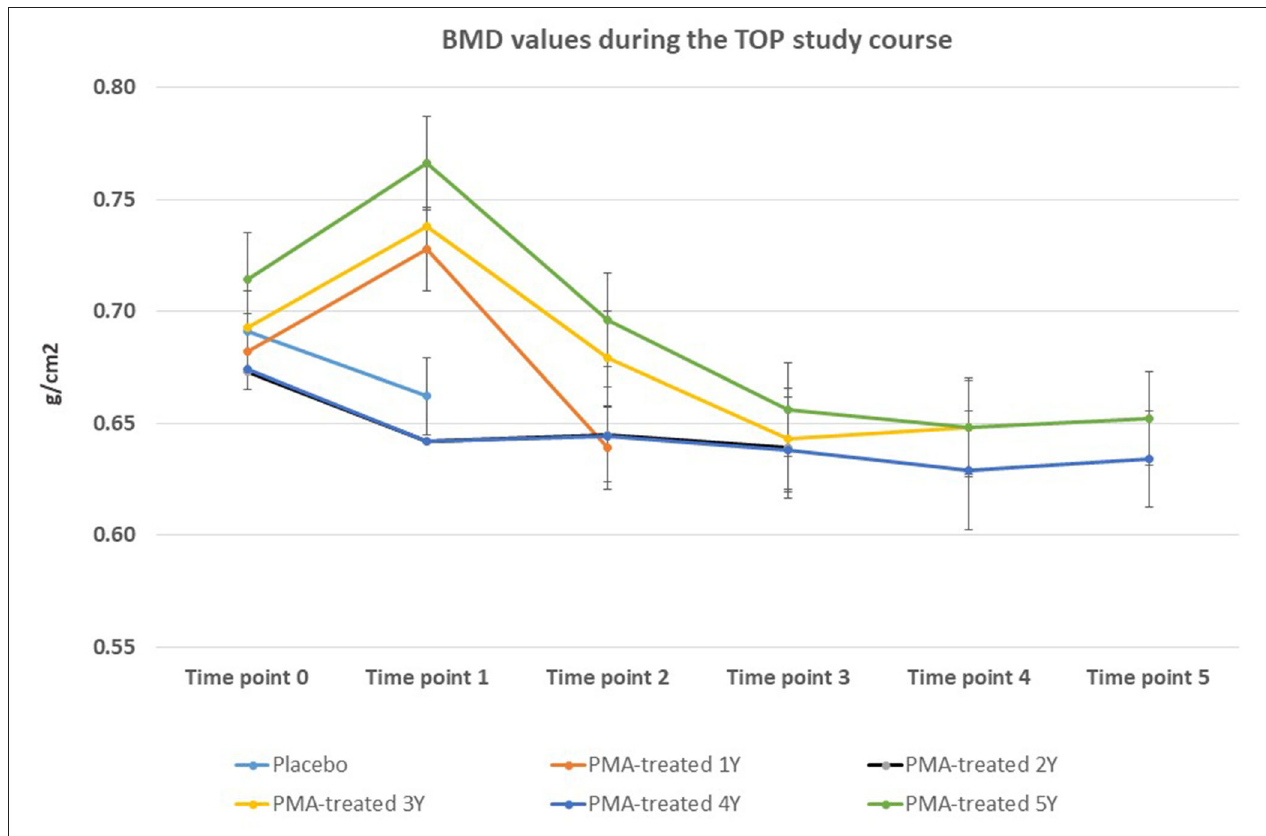
FIGURE 2 | Changes in BMD values from the beginning of the study (time point 0) until the end of study (time point 5) for Placebo and PMA-treated patients. A separate representation for the patients enrolled as Placebo group at time point 0 (later treated with PMA-zeolite from time point 1–5) and enrolled patients treated with PMA-zeolite from the beginning of the study (time point 0–5) is given in the Supplementary Figure 1